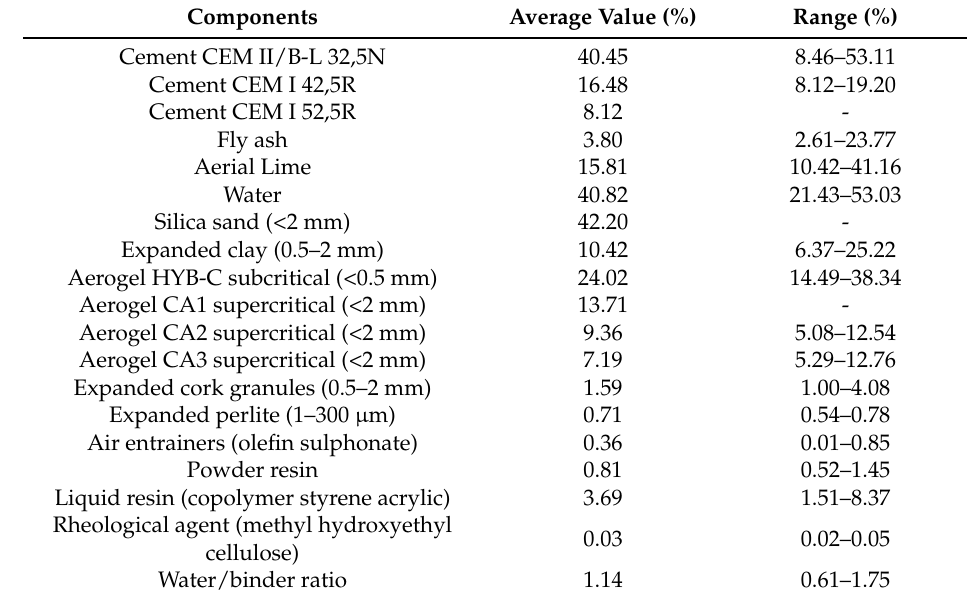
Table 1. Composition of the 85 mortars produced (component percentages by mass).